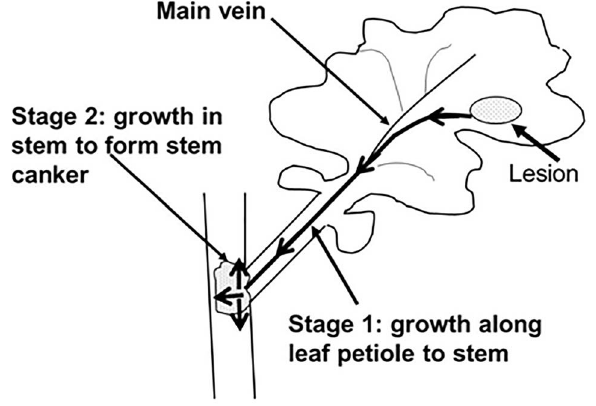
Figure 1. Stages of Leptosphaeriamaculans growth in oilseed rape. Assessment of quantitative resistance against growth of L. maculans in oilseed rape was considered in two stages; stage 1, resistance against growth from phoma leaf lesion along the main leaf vein and petiole to the stem; stage 2, resistance against growth in stem to produce stem canker; both stages were investigated in controlled environment experiments.